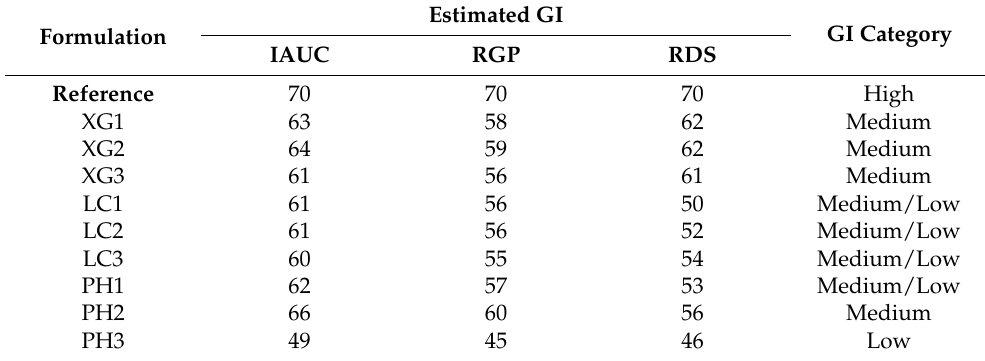
Table 3. Estimated GI values and categories of bread formulations based on a dry weight basis. Formulation